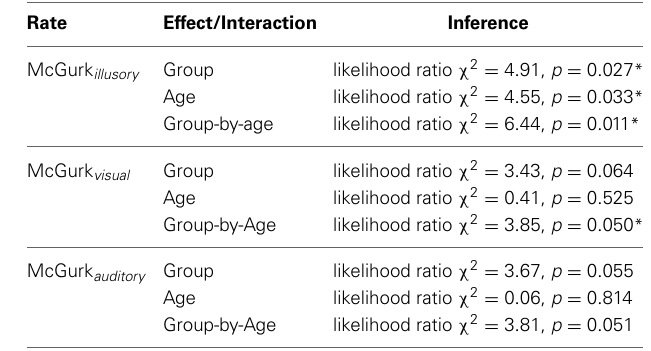
Table 2 | Effects of group and age on the McGurk illusory , McGurk visual and McGurk auditory rates. Asterisks denote effects significant at an uncorrected α -level of